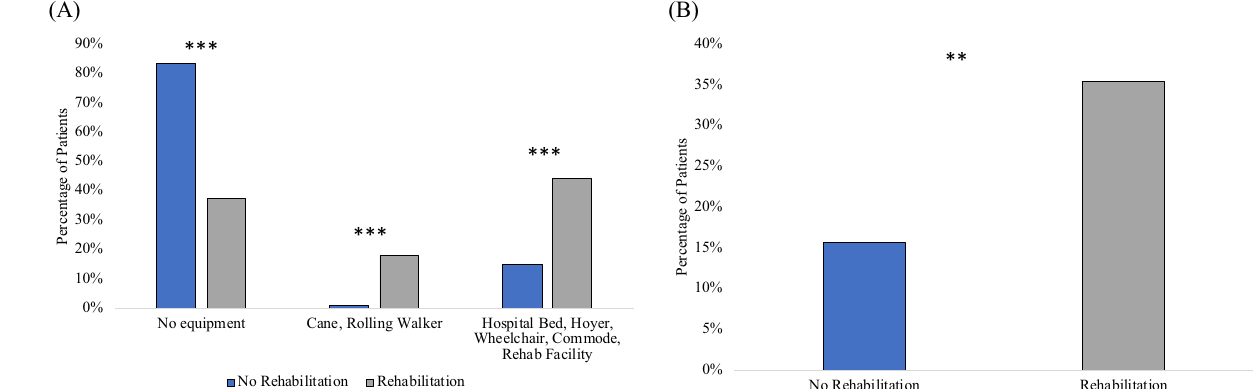
Figure 2. ( A ) Percentage of patients in the non-rehabilitation and rehabilitation group discharged: (i) with no equipment, (ii) with cane or rolling walker, (iii) with hospital bed, Hoyer, wheelchair, and/or commode (also referred to as durable medical equipment, DME), and to rehabilitation facility. ( B ) Patients discharged with or without supplemental oxygen equipment. *** indicates p < 0.001, ** indicates p < 0.01 (Chi Square).